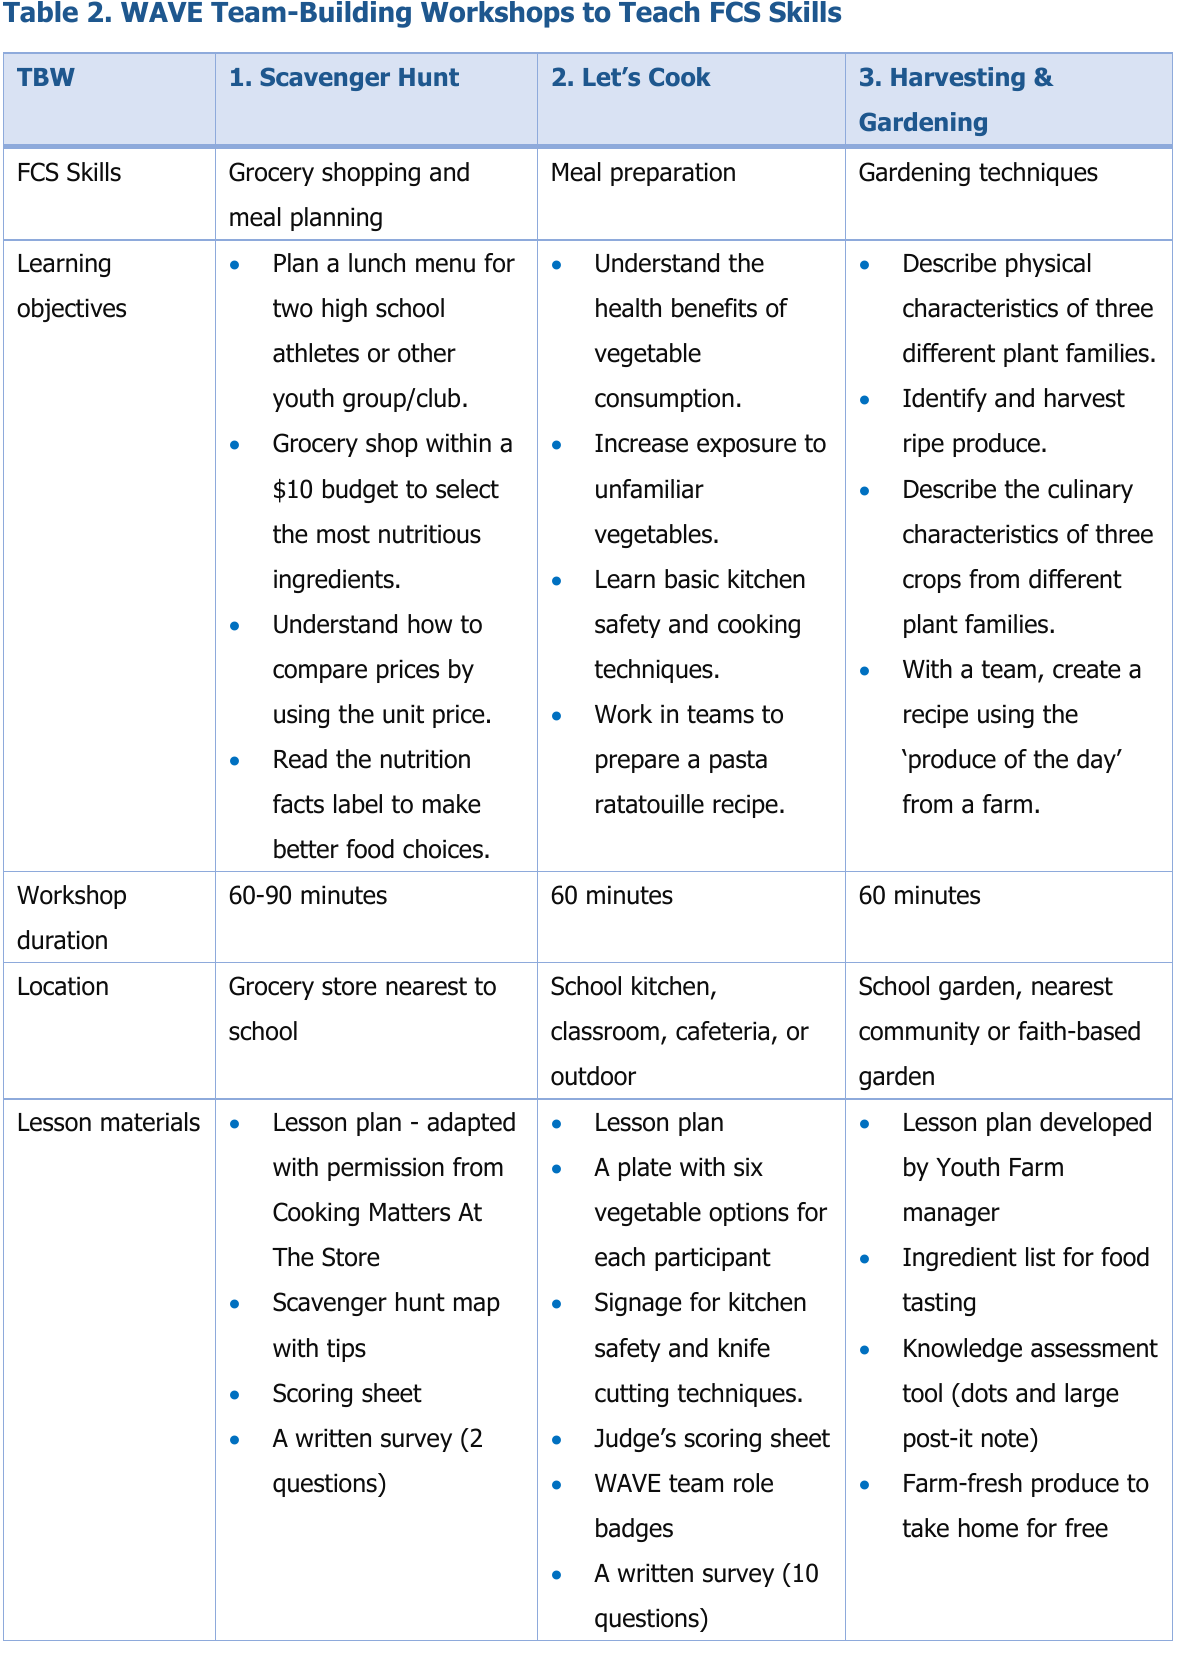
Table 2. WAVE Team-Building Workshops to Teach FCS